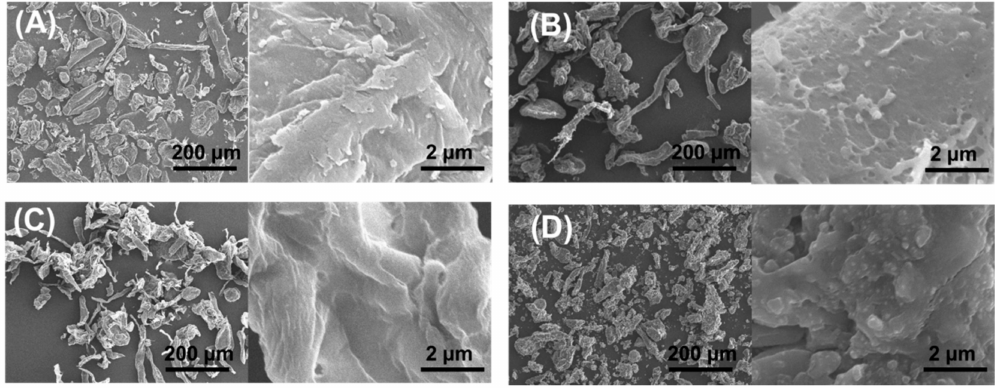
Figure 4. SEM images of: ( A ) CR; ( B ) CMCR; ( C ) C; and ( D )